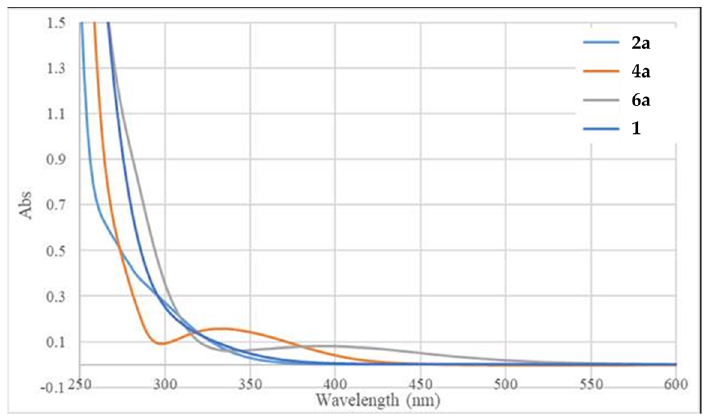
Figure 1. UV–visible spectra of hexacyclohexyldileads 1 , (PhS) 2 2a , (PhSe) 2 4a , and (PhTe) 2 6a (0.02 M in CHCl 3 ).